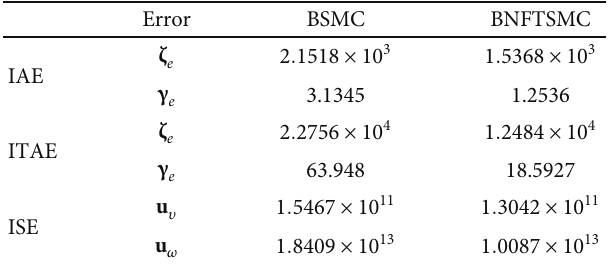
Table 2: Performance comparisons of di ff erent